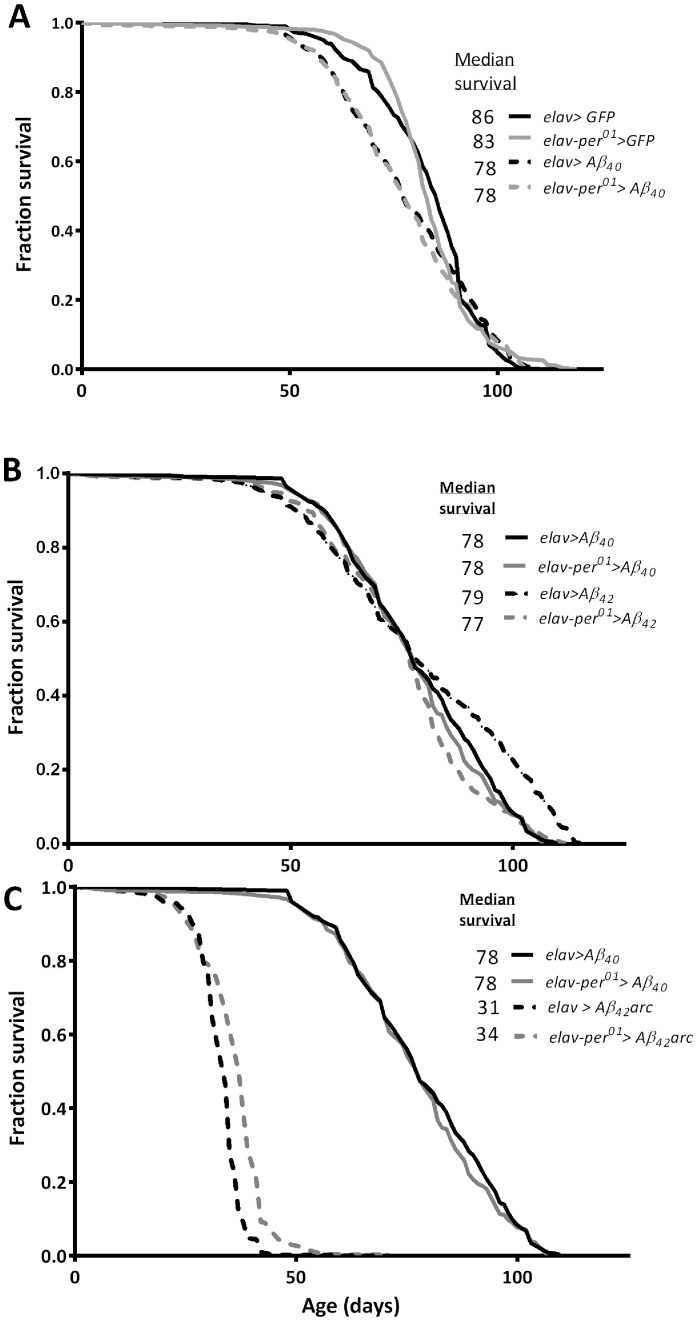
Longevity of flies expressing Aβ peptides.Survival curves and median lifespans of flies expressing GFP or Aβ40 (A), Aβ40 or Aβ42 (B), and Aβ40 or Aβ42arc (C). At least 400 individuals were used for each genotype tested. According to Mantel-Cox log rank test flies expressing Aβ42arc had significantly shortened lifespan (p<0.0001) relative to Aβ40 controls irrespective of whether their clock was disrupted by per-null mutation or not.